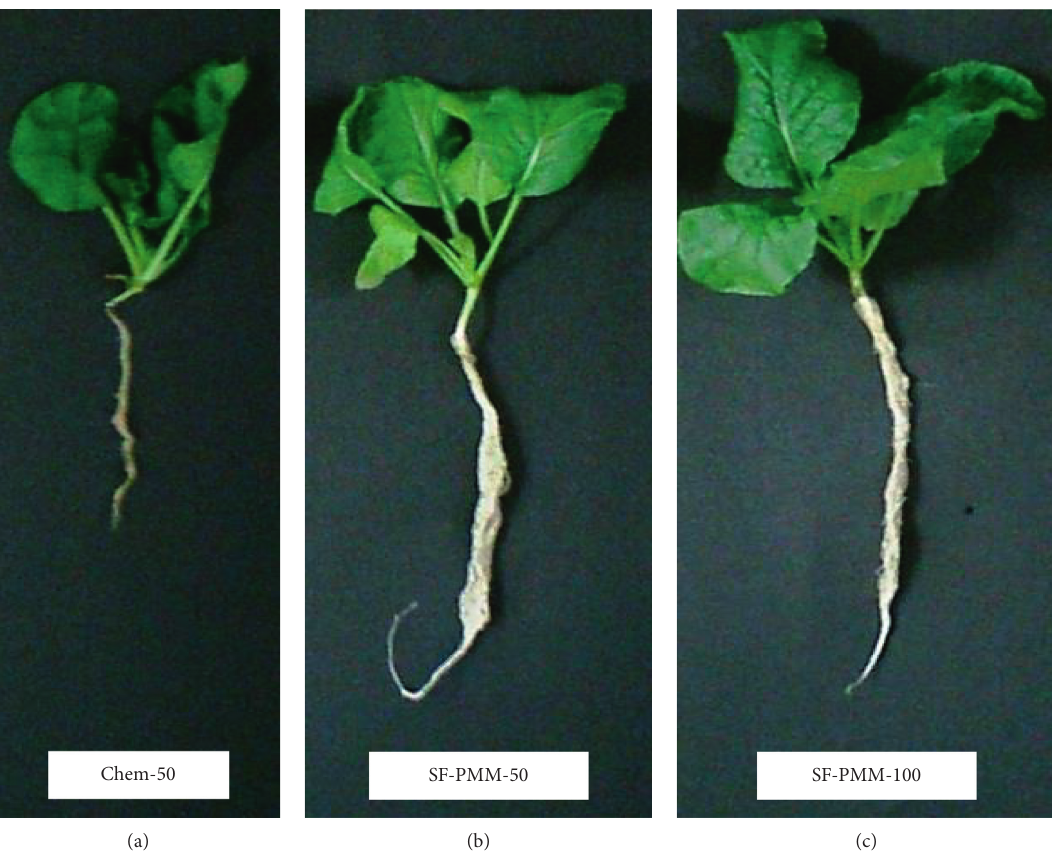
Figure 6: Photos of the komatsuna harvested in 5-week experiments. In the fifth week, one plant was taken randomly from each pot in the Control treatment: (a) chemical fertilizer of 50mgN, SF-PMM-50 treatment; (b) SF-PMM 50mg N and SF-PMM-100 treatment; (c) SF- PMM 100mg N. In Control treatment, N, P, and K were supplied from (NH 4 ) 2 SO 4 , CaH 4 P 2 O 8 , and KCl. In SF-PMM-50 and -100 treatments, N was supplied from SF-PMM, and the lack of P and K was compensated for by CaH 4 P 2 O 8 and KCl, respectively, if necessary. See for detail, Section